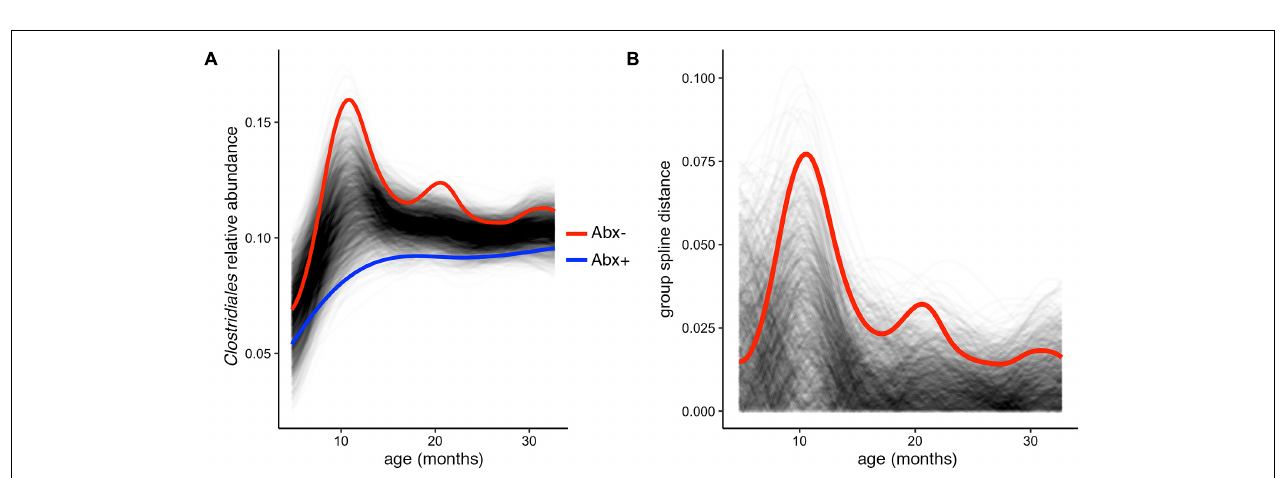
FIGURE 3 | Complete time series analysis highlights a significant and temporally maintained deficiency in butyrate-producing Clostridiales among infants exposed to antibiotics. (A) Results plot generated by the permuspliner test, showing enriched abundance of Clostridium groups IV and XIV in infants not exposed to antibiotics (Abx–, red line). (B) Corresponding distance plot output, showing that the observed difference between the groups exceeds the random permuted distribution 997/1000 times, which supports the statistically significant finding ( p =